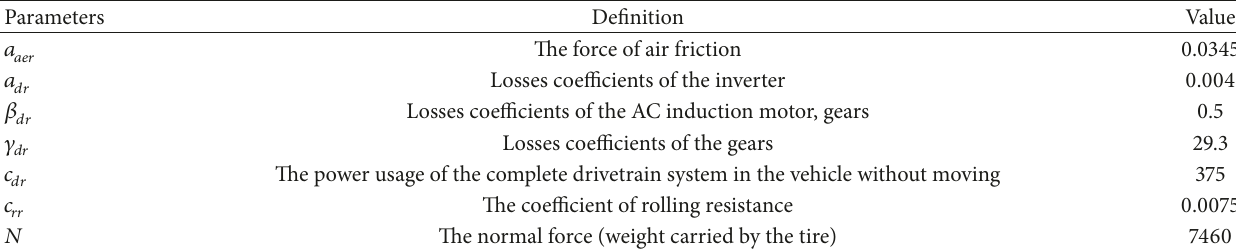
Table 1: Parameters of energy consumption model.